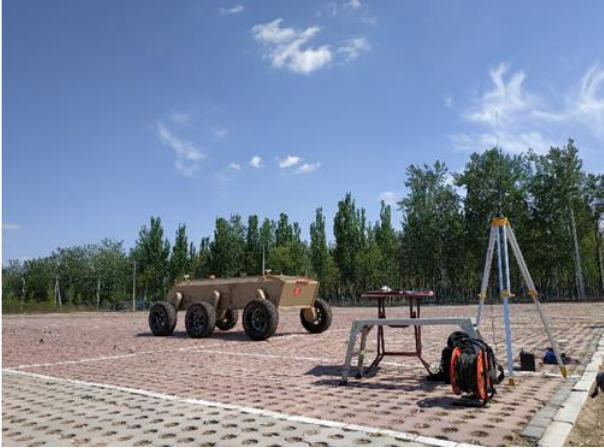
Figure 11. Experimental platform and the RTK-GNSS base station.